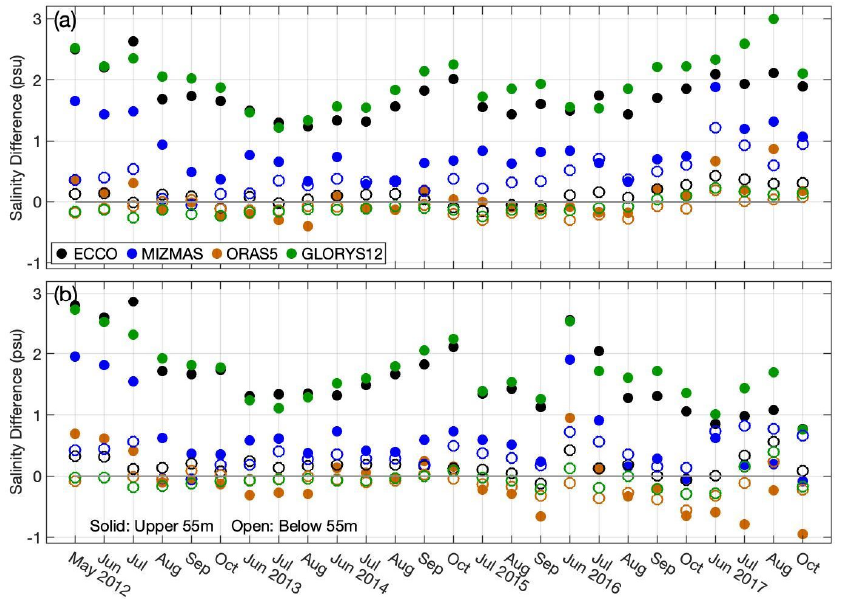
Figure 11. Differences in salinity (psu) depth profiles of each product at each SIZRS latitude averaged monthly from 2012–2017 separated by vertically-averaged (solid dot) upper 5 m to 55 m region and the (opened dot) lower 55 m to 207 m region for ( a ) model minus SIZRS, and ( b ) model minus EN4.